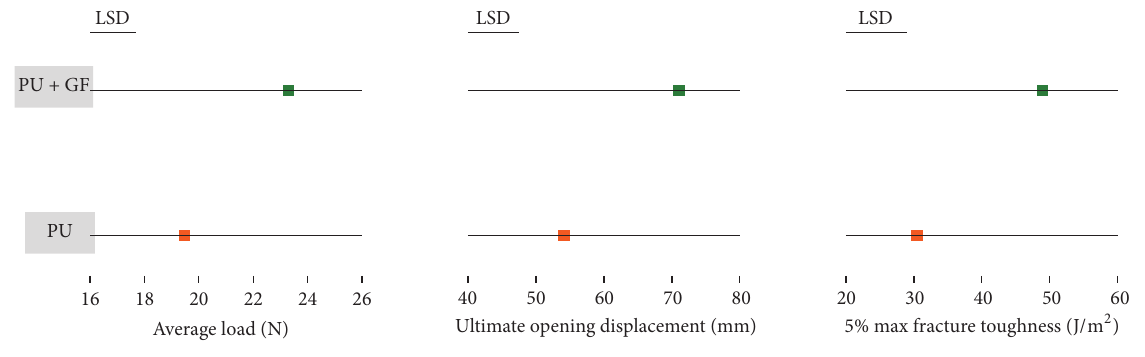
Figure 5: Effects of reinforcement of polyurethane adhesive (PU) with glass-fibre (GF) on some critical fracture characteristics of the laminated birch wood specimens.